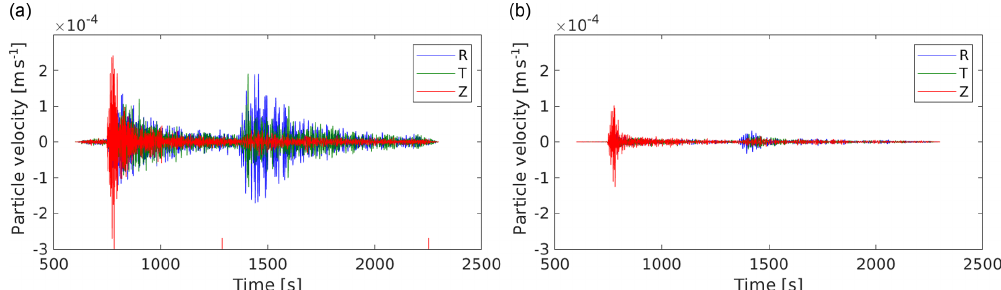
Figure 3. Comparison of the Mexico M8.1 event (Table 1) recorded on (a) a soft-sediment site in Groningen (seismometer G300, epicentral distance 9359km) and (b) at a hard-rock site (seismometer HGN, epicentral distance 9378km) in the south of the Netherlands. R is the radial, T is the transverse, and Z is the vertical component of the seismometer. In panel (a) , the red ticks indicate the 1000s window. The direct P wave arrives at 750s on the Z component, while the direct S wave arrives on the R and T components at